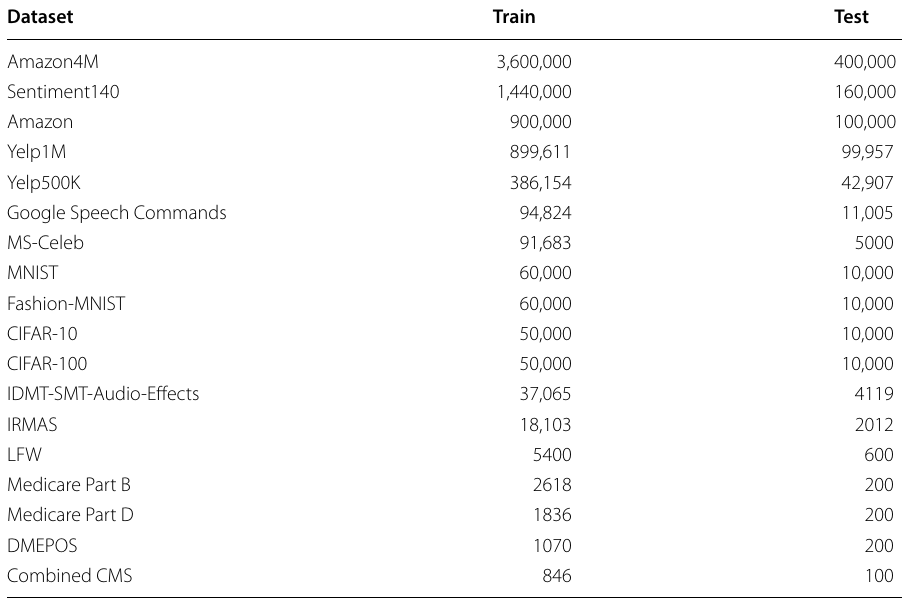
Table 5 Train and test size per